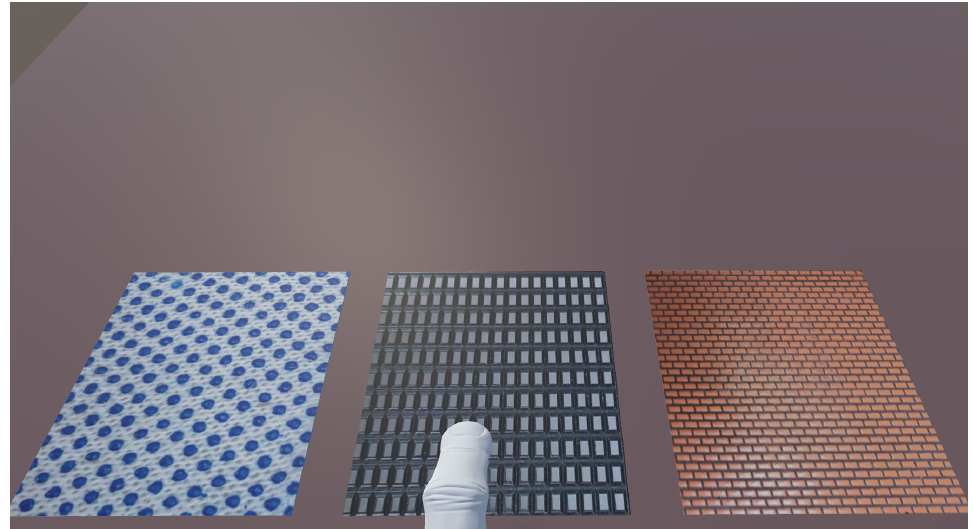
Figure 6. The scenes of the virtual environment used in our experiments.